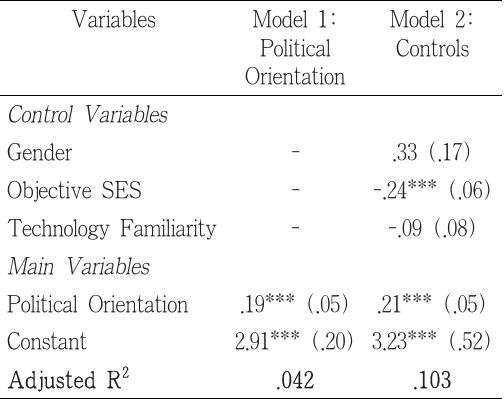
<Table 4> Results of the regression